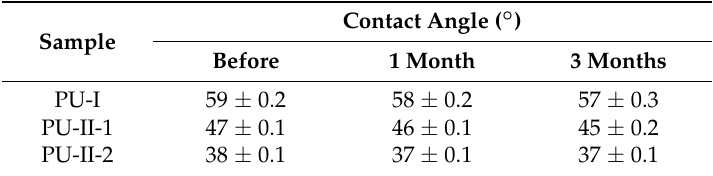
Table 4. Contact angle of obtained PURs before and after 1 and 3 months of incubation in PBS.